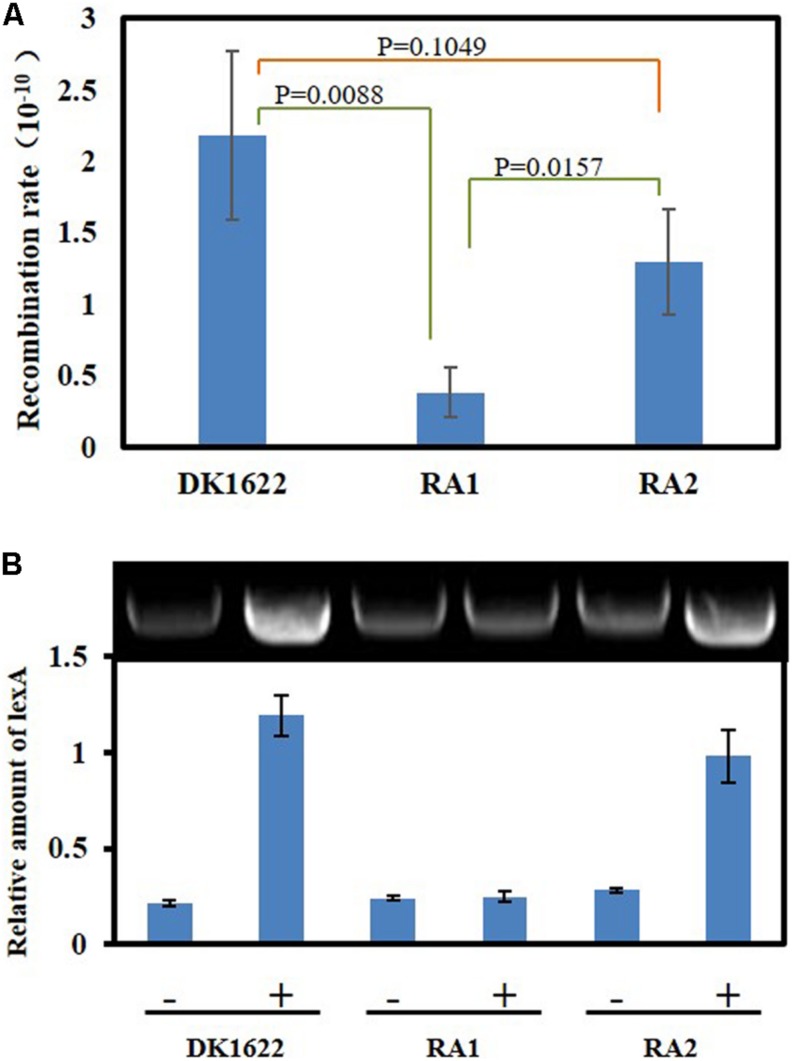
Intracellular DNA recombination rate and induction analysis of the lexA gene. (A) The cellular recombination rate of DK1622, RA1, and RA2. The two ends of the resistance gene (kan) have homologous DNA sequences with the two ends of the insertion site, respectively, and the kan gene is transferred into the M. xanthus through electrical transformation. The recombination rate was calculated by measuring the proportion of kanamycin-resistant colonies. (B) The inducibility of the lexA gene. Myxococcus lexA is a known SOS gene induced through LexA-dependent SOS response, and herein, its UV inducibility represents the activation of LexA-dependent SOS response. The strains were irradiated with 15 J/m2 UV irradiation (+) or mock treatment (–), and the transcription of lexA was determined by RT-PCR.